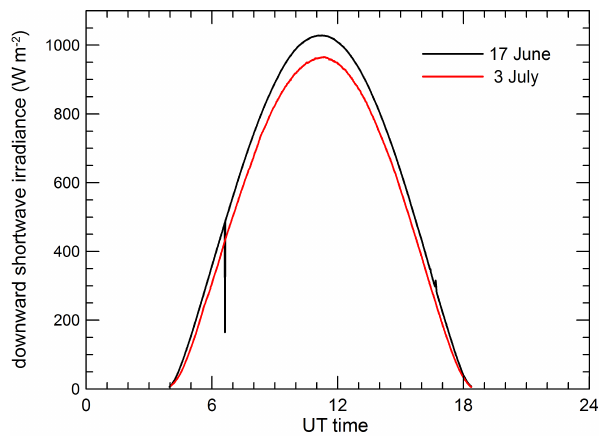
Figure 27. Time evolution of the downward solar irradiance ob- served at Lampedusa on 17 June and 3 July 2013.